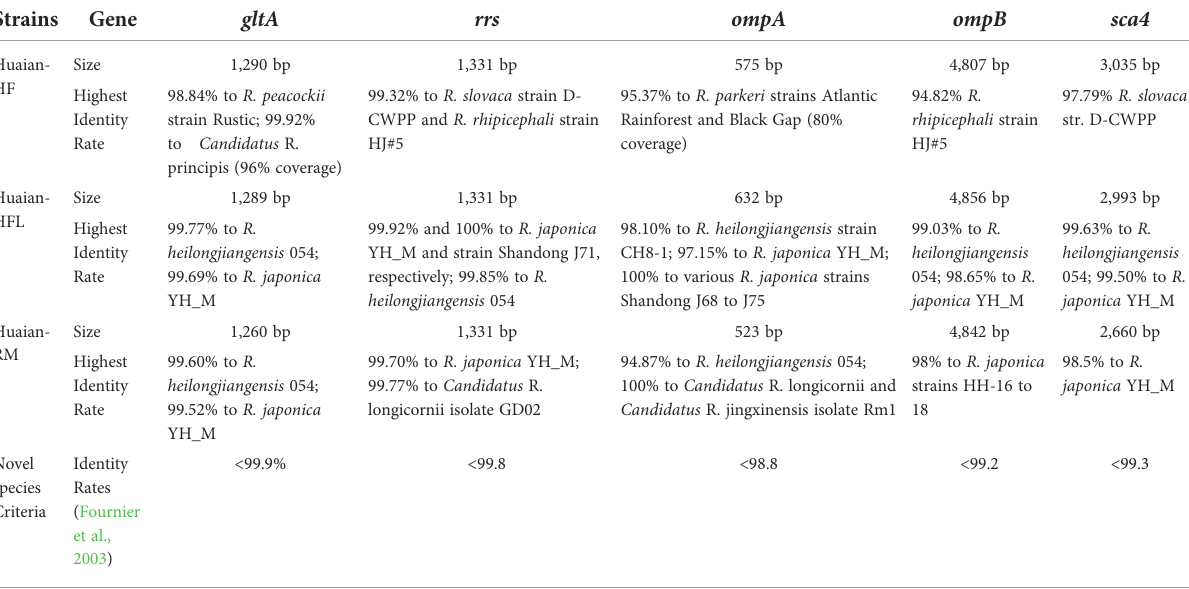
TABLE 2 Identity rates of the genes from the identi fi ed strains with various validated or unvalidated Rickettsia spp.